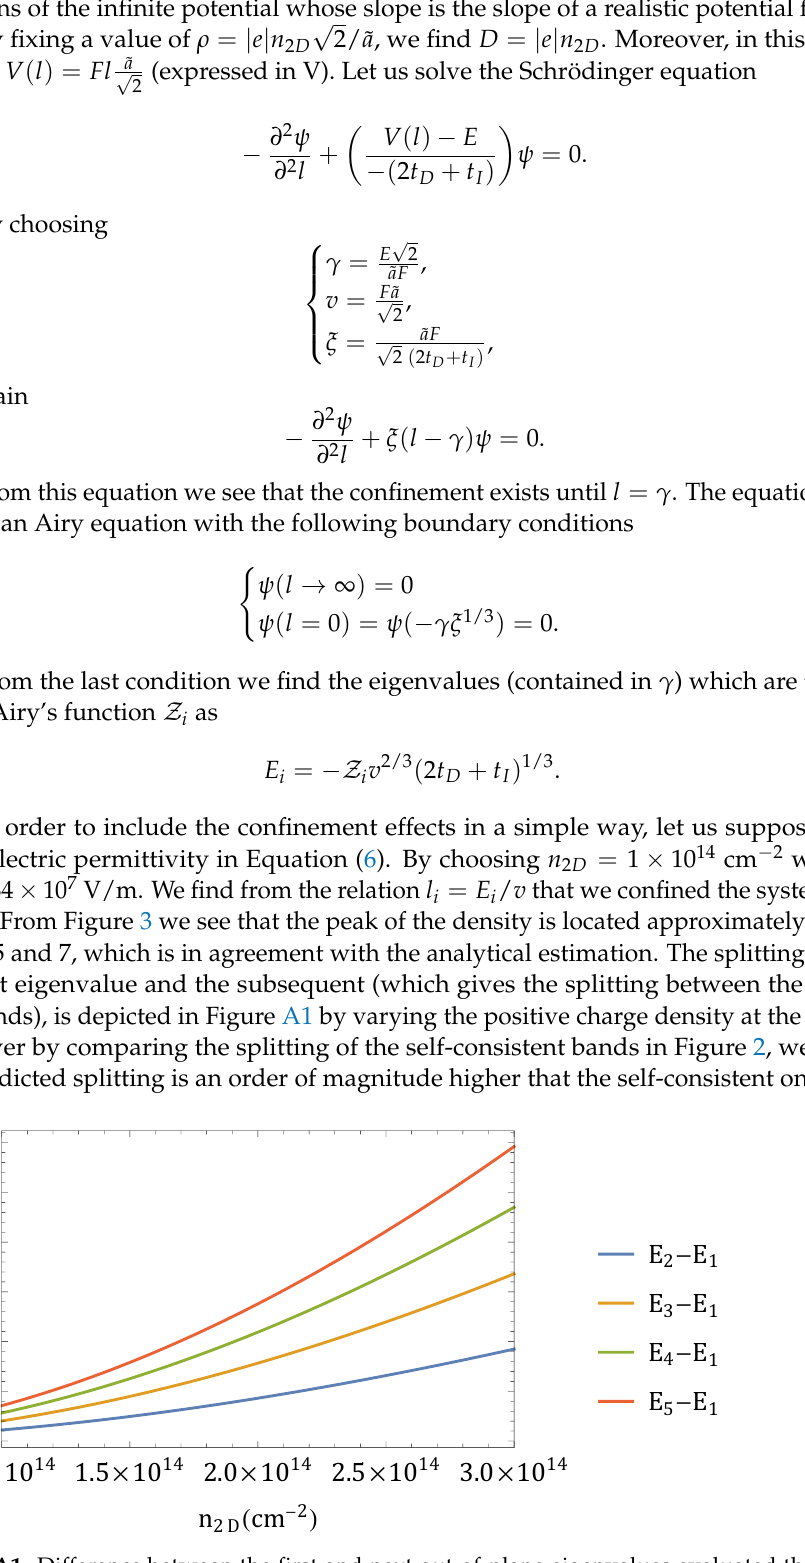
Figure A1. Difference between the first and next out-of-plane eigenvalues evaluated through the analytical approach as a function of the positive density charge at the